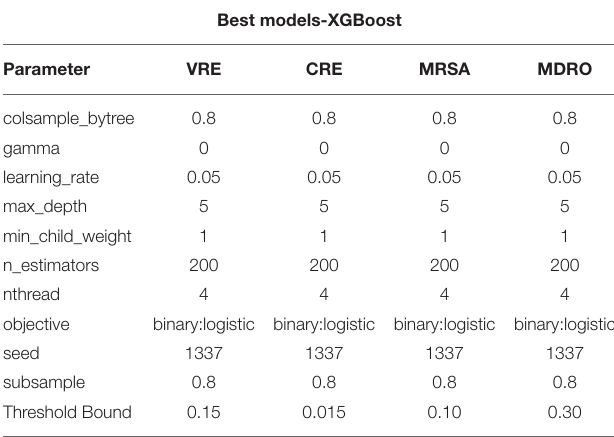
TABLE 3 | Model parameters for best performing XGBoost models. Best